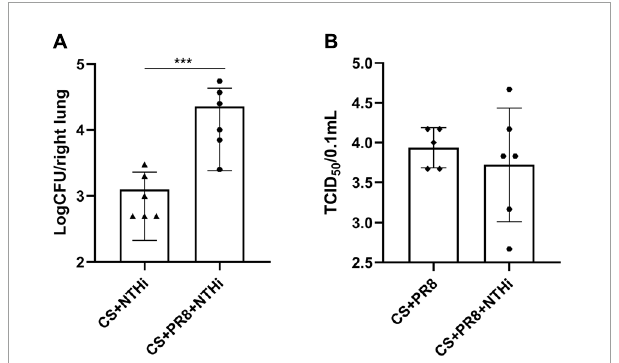
FIGURE5 Replication of PR8 and NTHi in AECOPD mice. At 24 h post-NTHi infection, lung homogenates were added to chocolate agar plates containing vancomycin to determine bacterial CFU (A) , and the supernatants of lung homogenates were added to MDCK cells to determine viral TCID 50 (B) . Data are expressed as mean ± SD ( n = 6). *** p <